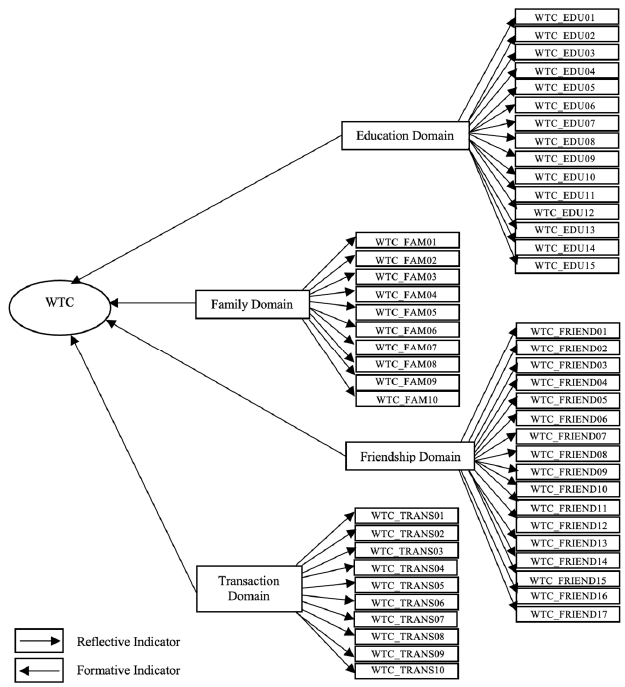
Figure 1. The measurement model of WTC.